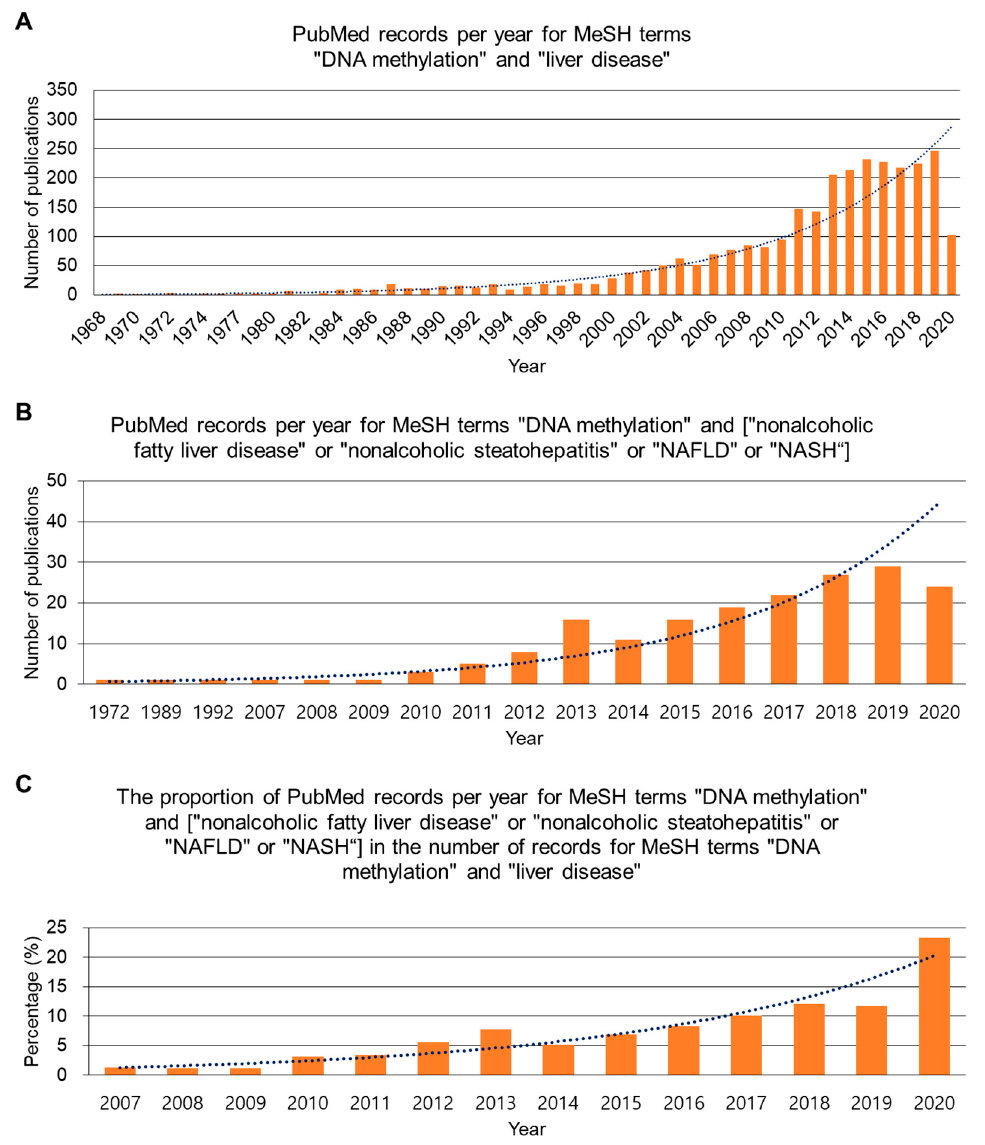
Figure 1. The number of publications on DNA methylation in nonalcoholic fatty liver disease / nonalcoholic steatohepatitis (NAFLD / NASH) is increasing. ( A ) The number of publications in PubMed per year for the terms of medical subject headings (MeSH), “DNA methylation” and “liver disease”. X -axis scale is displayed every 2 years. ( B ) The number of publications in PubMed per year for the terms of MeSH, “DNA methylation” and (“nonalcoholic fatty liver disease” or “nonalcoholic steatohepatitis” or “NAFLD” or “NASH”). ( C ) The proportion of PubMed records per year for MeSH terms shown in panel B in the number of PubMed records for MeSH terms shown in panel A. The records until September 2020 were included.